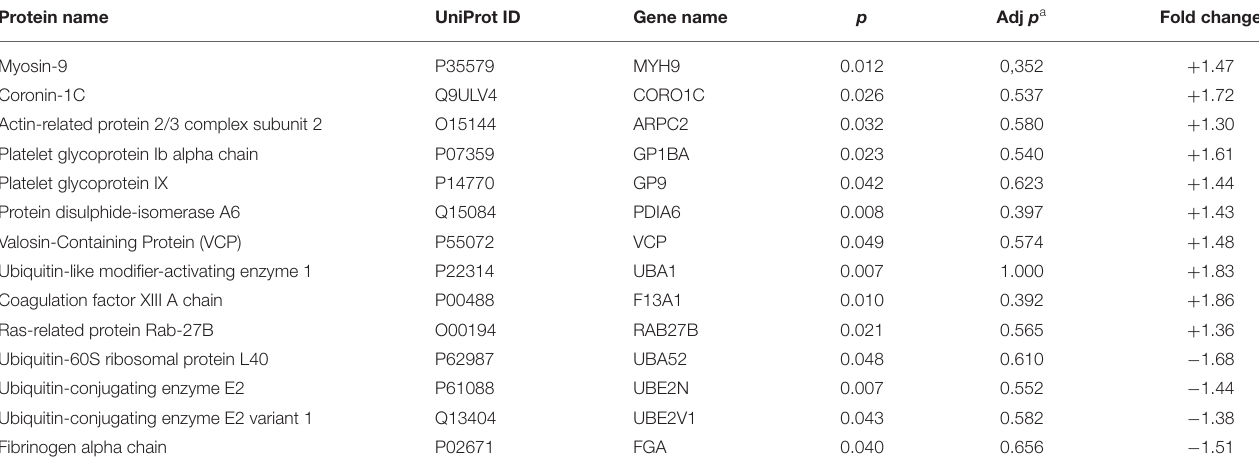
TABLE 1 | List of proteins identified as differentially abundant in CE ( + ) vs. LAA (–) clots. Protein name